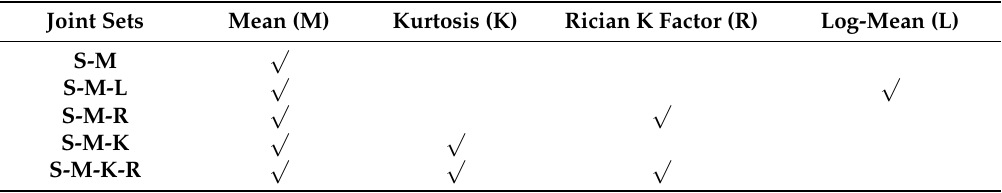
Figure 8. The comparisons of remarkable sets on the features.